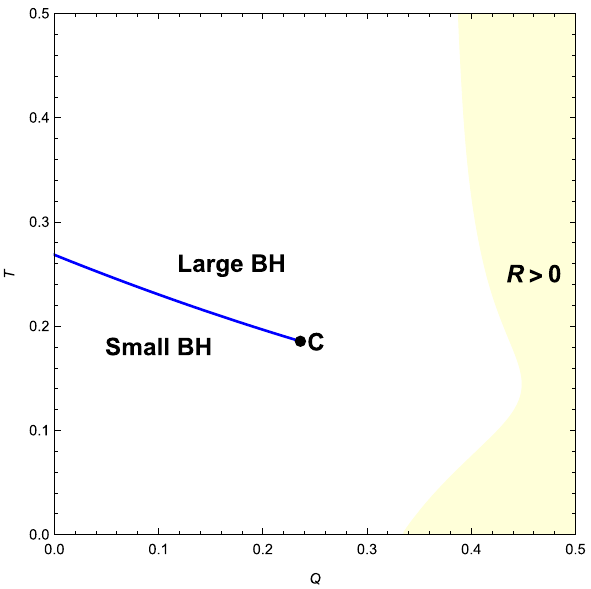
Fig. 7 Phase structure of a RN black hole in a cavity in the Q - T dia- gram. The first-order phase transition line separating Large BH and Small BH is displayed by the blue line and terminates at the critical points (black dot). In the yellow region, R > 0 which gives δ = 3 in both